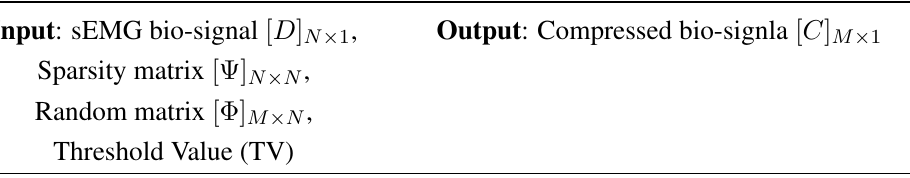
Table 2. Algorithm I: compressed sEMG bio-signal.